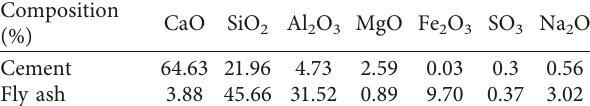
Table 1: Main chemical compositions of cement and fly ash.